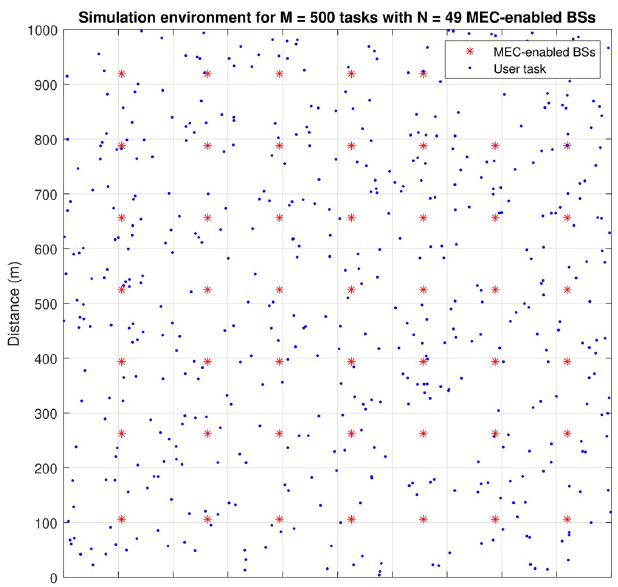
Figure 3. The location of BSs and users within simulation region. Table 3. Employed simulation parameters with corresponding